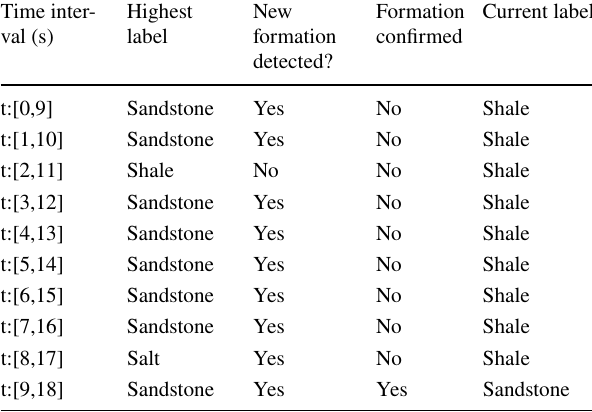
Table 14 Example for real-time rock classification Time inter- Highest New val (s) label